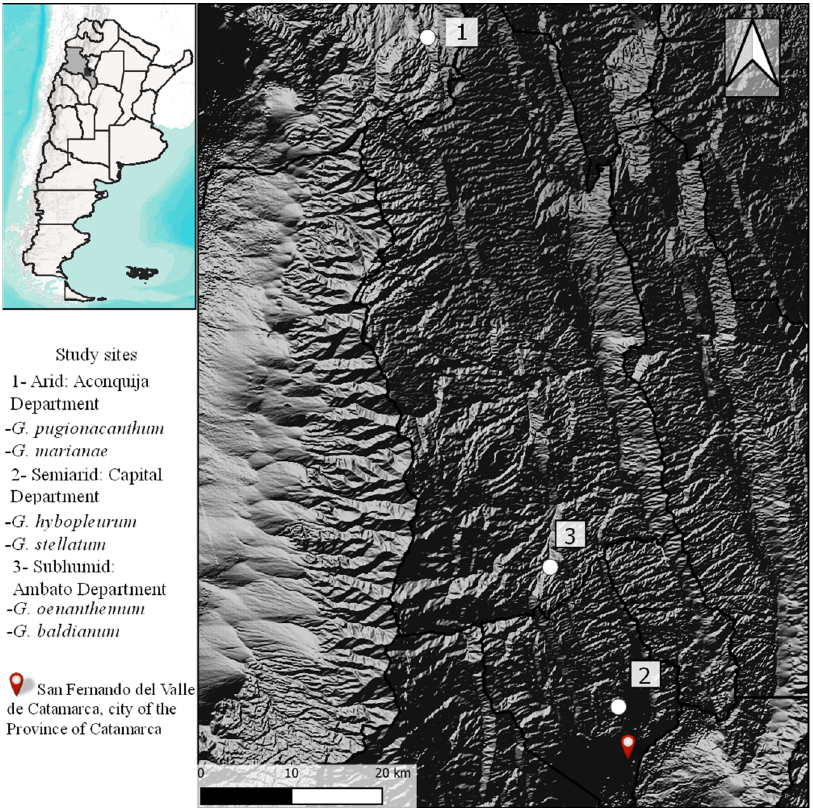
Figure 1. Location of the three collection sites of six species of Gymnocalycium along a precipitation gradient in the province of Catamarca, Argentina. Numbers/circles indicate the location of the study sites. 1—Aconquija department ( G. pugionacanthum, G. marianae ), 2—Capital department ( G. hy-